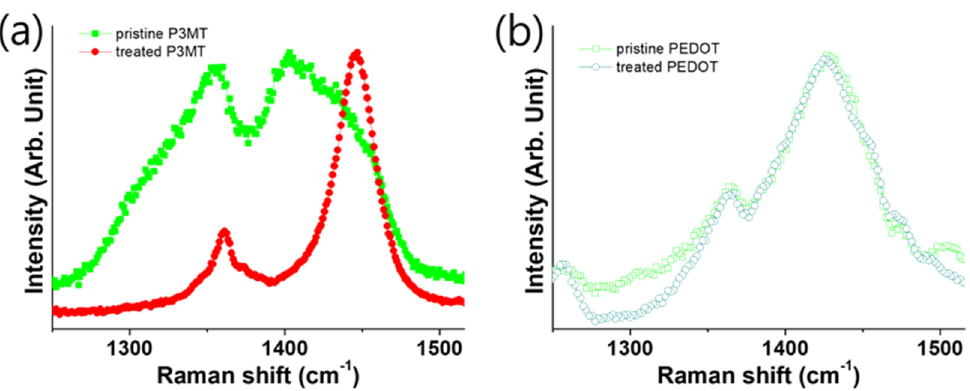
Figure 5. Magnified Raman shift spectra between 1200 and 1550 cm − 1 . ( a , b ) P3MT and PEDOT nanowires prepared in different pH environments (square-dotted line: pristine, circle-dotted line: alkali treated).